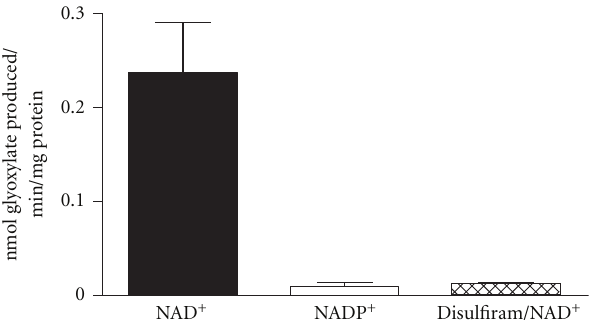
Figure 2: Conversion of glyoxal to glyoxylate in liver tissue homo- genates. Incubations contained 0.2mM glyoxal, 50 mM TRIS pH 9.0, 100mM KCl, 1mM EDTA, 1mg human liver lysate, 10 minutes, 37 ◦ C. Reaction additions: 1 mM NAD + , 1mM NADP + , 1mM